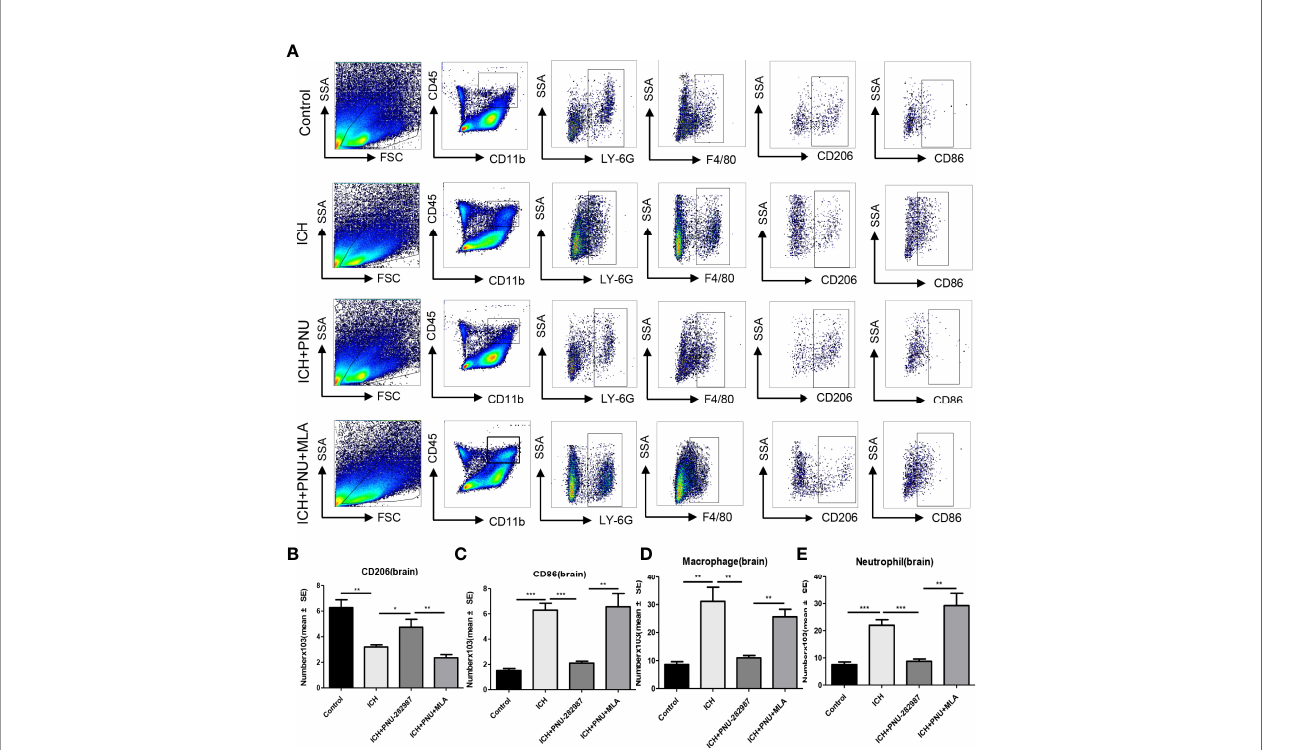
FIGURE 7 | Activating a 7nAChR mediated neuroprotection in ICH by regulating microglia/macrophage polarization toward an anti-in fl ammatory phenotype. (A) Typical fl ow cytometric graph showing the gating strategy for CD45+CD11b+F4/80+ macrophages, CD45+CD11b+Ly6G+neutrophils, CD206+ anti-in fl ammatory macrophages and CD86+ pro-in fl ammatory macrophages populations in brain. (B) Quantitative data of anti-in fl ammatory macrophages expression in brain at 7 days after ICH. (C) Quantitative data of pro-in fl ammatory macrophages expression in brain at 7 days after ICH. (D) Quantitative data of macrophages expression in brain at 7 days after ICH. n = 6 per group. (E) Quantitative data of neutrophils expression in brain at 7 days after ICH. Data are presented as mean ± SE; *p < 0.05; **P < 0.01; ***P < 0.0001.